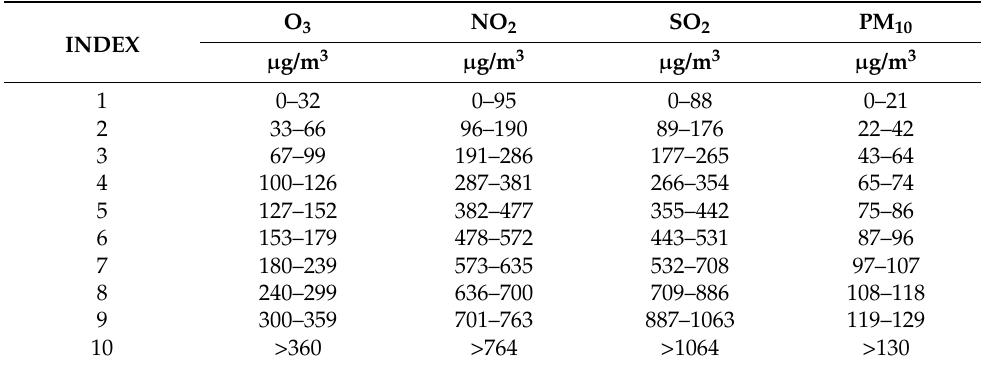
Table 1. Boundaries Between Index Points for Each Pollutant.